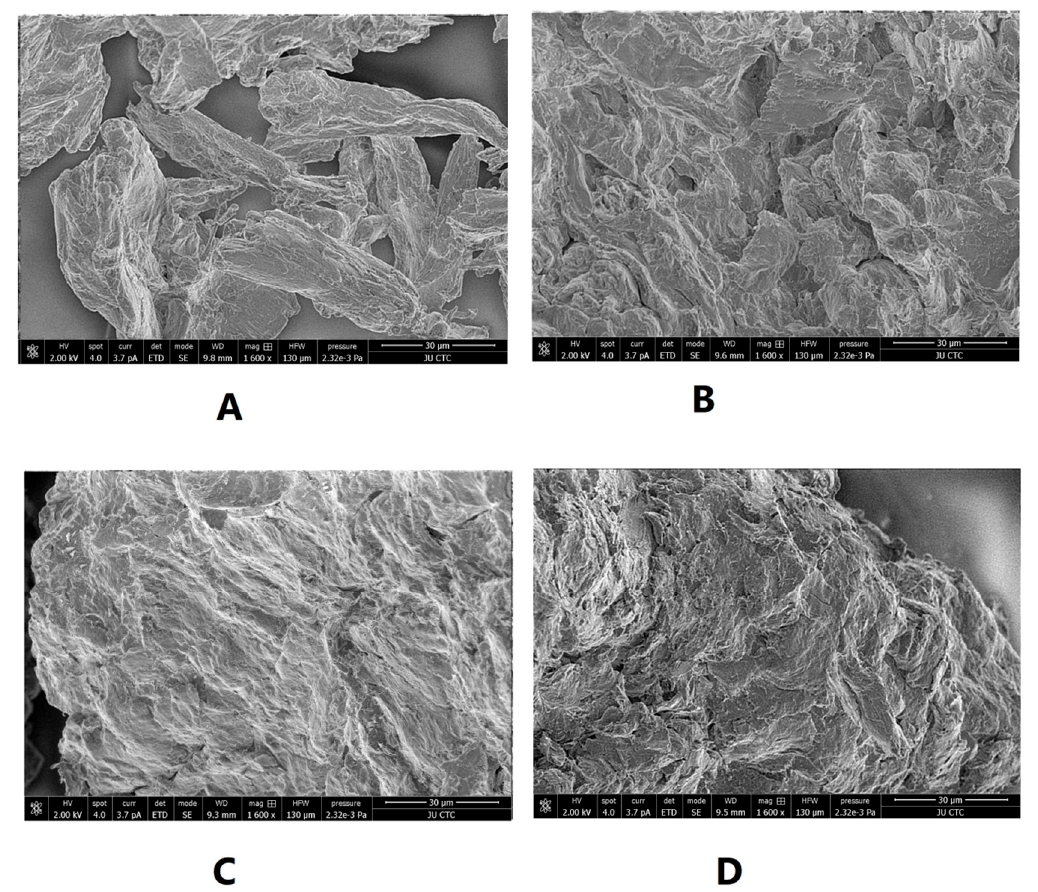
Figure 4. SEM of non-compacted Avicel PH-101 101 ( A ), roller compacted Avicel-1st compaction cycle ( B ), roller compacted Avicel-2nd compaction cycle ( C ), and roller compacted Avicel-3rd compaction cycle ( D ) at magnification of 1600×.